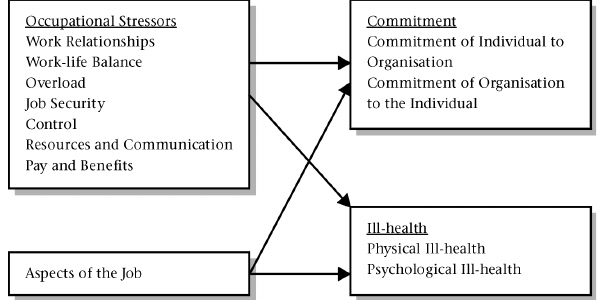
Figure 1: Model of occupational stress, commitment and